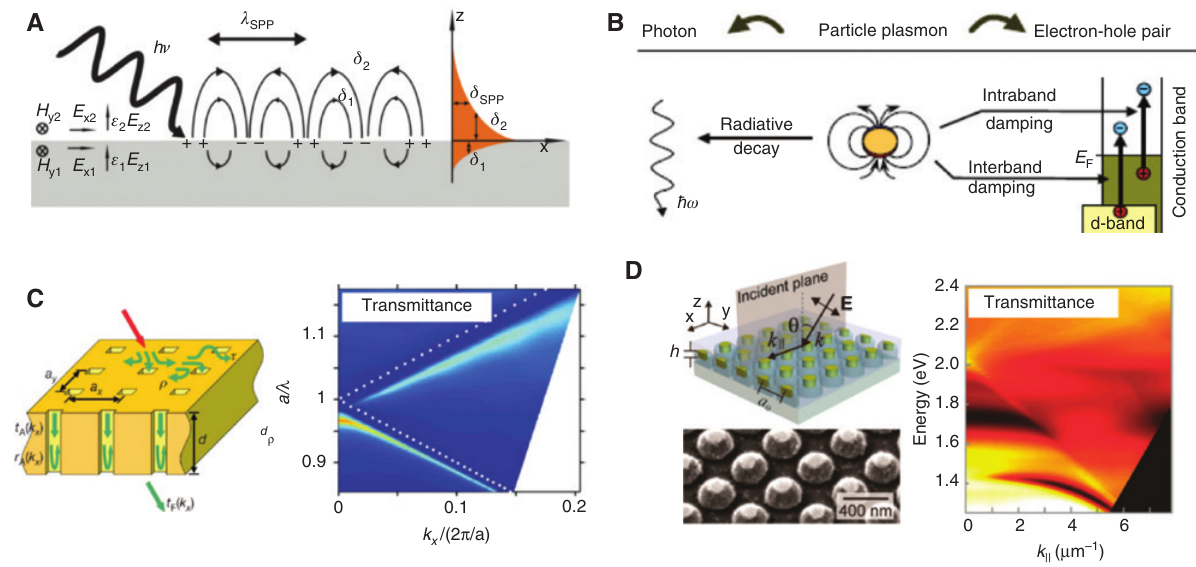
Figure 2: Schematic illustrations of plasmonic modes in different types of plasmonic building blocks. (A) Surface plasmon polariton (SPP) modes at the continuous metal-dielectric interfaces. (B) Localized surface plasmon (LSP) modes in individual metal nanostructures [41]. (C) Delocalized Bloch-SPP modes in the metal thin film perforated with periodic nanohole arrays [42]. (D) Delocalized out-of-plane lattice plasmon modes in Au nanoparticle arrays